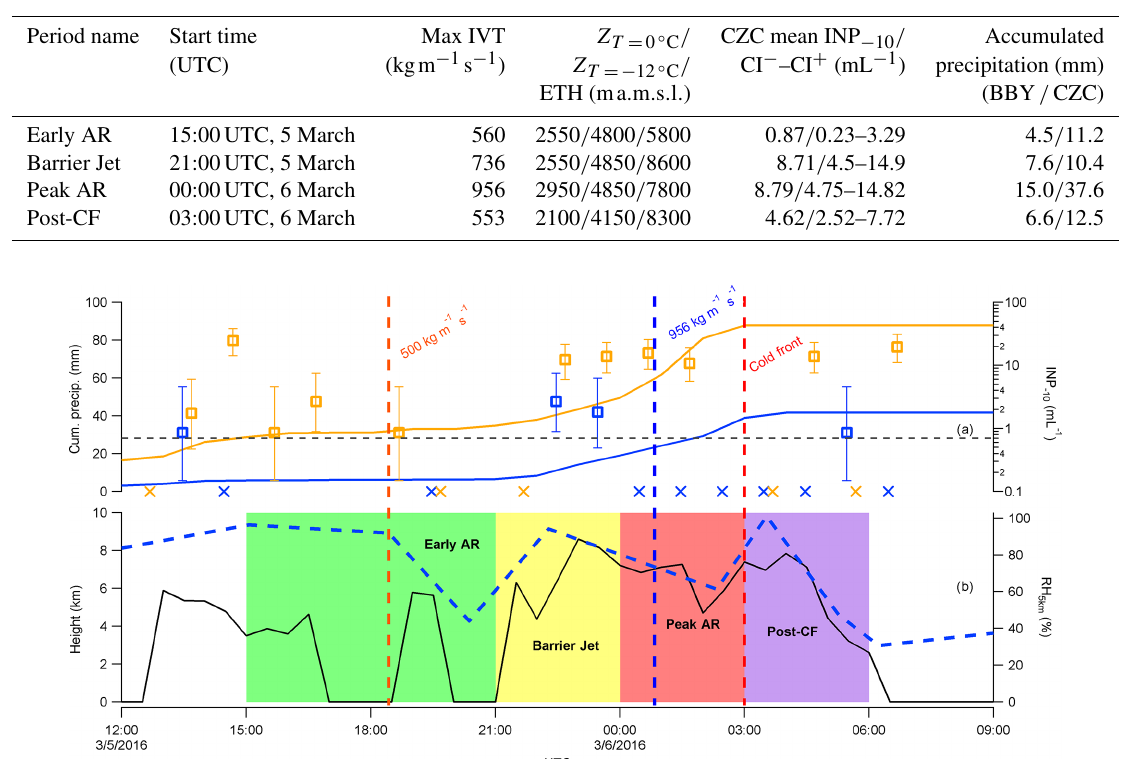
Figure 4. (a) Time series of INP − 10 (mL − 1 ) at BBY (box-and-whisker plot – blue), at CZC (box-and-whisker plot – orange), accumulated precipitation (mm) at BBY (blue line) and accumulated precipitation at CZC (orange line). Blue (orange) “X” on temporal axis indicates precipitation sample with INP − 10 below AIS detection limit at BBY (CZC). Timing of IVT surpassing 500kgm − 1 s − 1 and cold-front transit are annotated in red dashed lines. Horizontal black dashed line displays the AIS detection limit 0.7mL − 1 . (b) S-band radar-derived echo top (ET – black solid) and bright band (BB – black dashed) height (kma . m . s . l . ) at CZC. Also shown is RH 5km (%) from soundings (blue dashed). Shading depicts Early AR, Barrier Jet, Peak AR, and Post-CF periods (Sect.